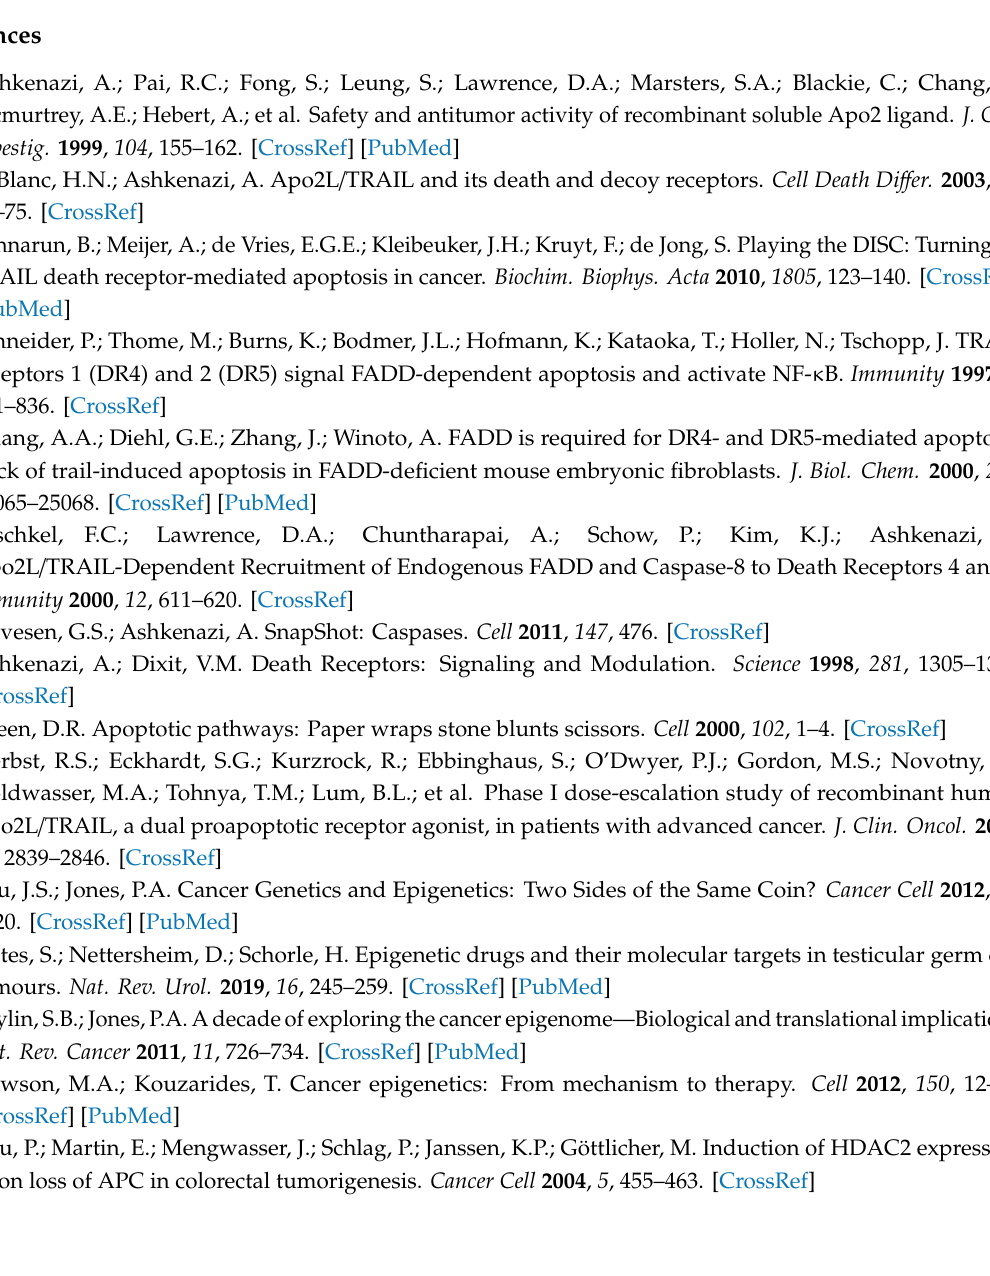
Figure S1: 5 µ M of HDAC inhibitors RGFP966 or PCI34051 increase the sensitivity of DLD-1 (A) or WiDr (B) cells to rhTRAIL 4C7 or DHER, Figure S2: HDAC inhibitors increase TRAIL-mediated apoptosis, Figure S3: After 72 h transfection with siRNA, WiDr cells were treated with 25 ng / mL rhTRAIL 4C7 or DHER and apoptotic cells were detected using the Violet Ratiometric Membrane Asymmetry Probe, Figure S4: Alterations of death receptor expression after incubating with 10 µ M RGFP966 or PCI34051 for 24 h or 48 h on DLD-1 (A) or WiDr (B) cells, Figure S5: SAHA or Entinostat changes cell cycle after incubating for 24 h on DLD-1 (A) or WiDr (B) cells. Red peaks represent G0 / G1 and G2 phase, Table S1: List of primer sets used for